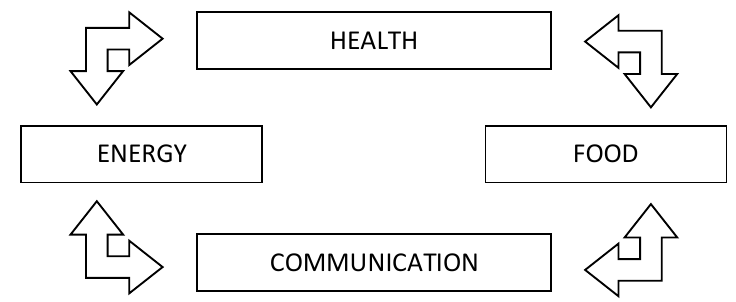
Figure 1: Global Capitalism. Basic